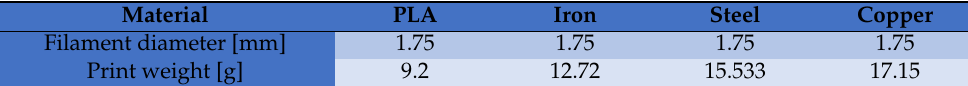
Table 3. Weight of a sample made from different materials.